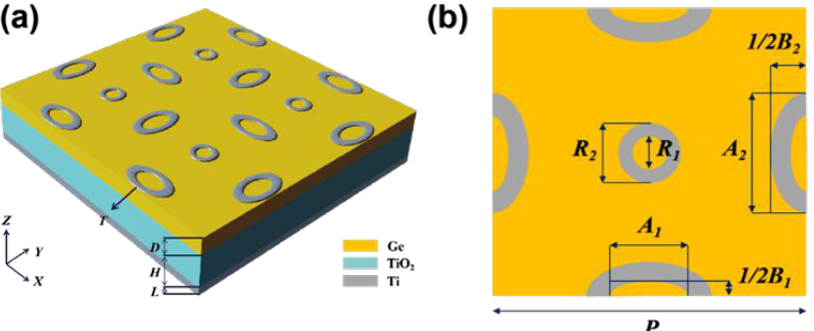
Figure 1. Schematic diagram of the designed meta-structure absorber. ( a ) Three-dimensional diagram includes a top array of Ti meta-structure and three layers of Ge, TiO 2 , and Ti. The geometric parameters used to characterize the thickness in the figure are T—20 nm, D—250 nm, H—490 nm, and L—120 nm. ( b ) One period of the Ti array. The geometric parameters used to characterize the size in the figure are P—2000 nm, R 1 —220 nm, R 2 —400 nm, A 1 —500 nm, A 2 —800 nm, B 1 —200 nm, and B 2 —460